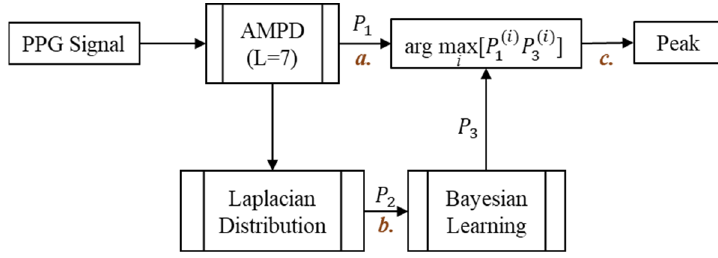
Figure 7. AMPD-BL block diagram.